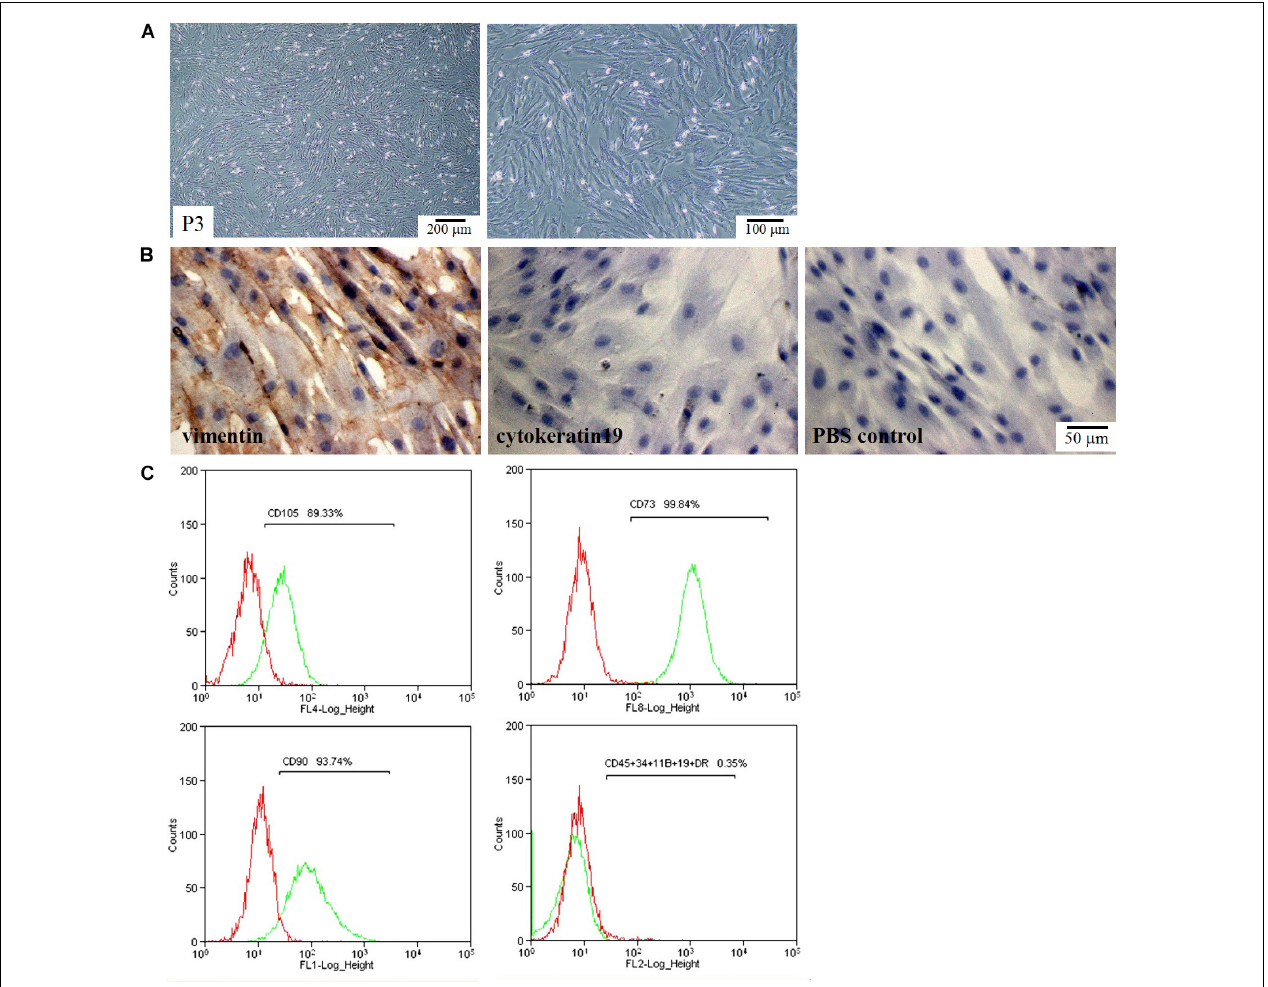
FIGURE 1 | Morphological and phenotypic characteristics of hAMSCs. (A) Optical microscope images of hAMSCs. Left: 40 × , Right: 100 × . (B) The expression of vimentin and cytokeratin 19 (CK19). (C) Flow cytometric analysis of cell surface makers. Shown here are the sorted sub-populations that stained positively with CD105, CD73, and CD90, and negatively with CD45, CD34, CD11B, CD19, and HLA-DR. Red: Isotype control; Green: